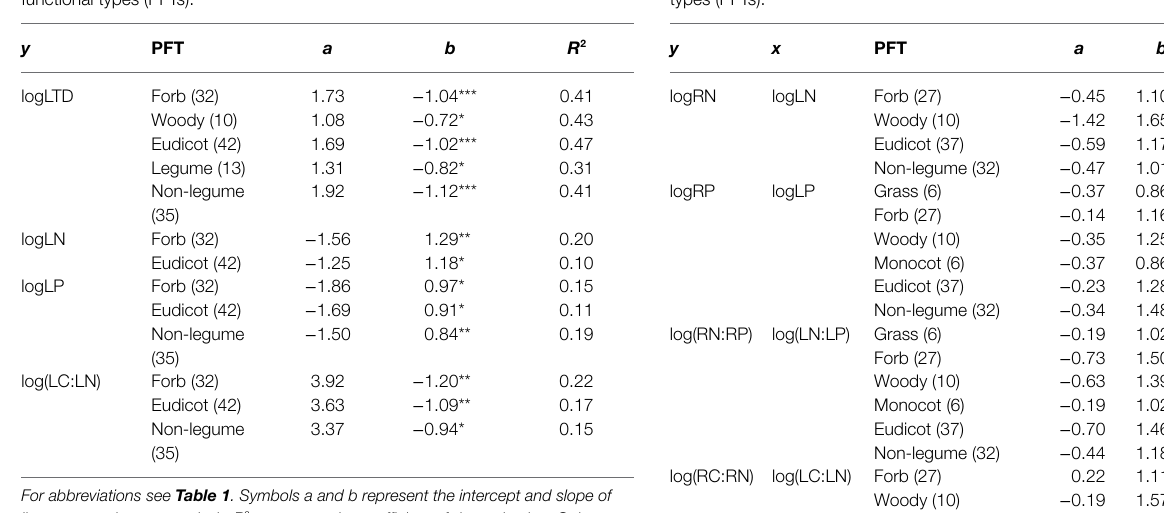
TABLE 4 | Correlations between leaf and fine-root traits for different functional types (PFTs).